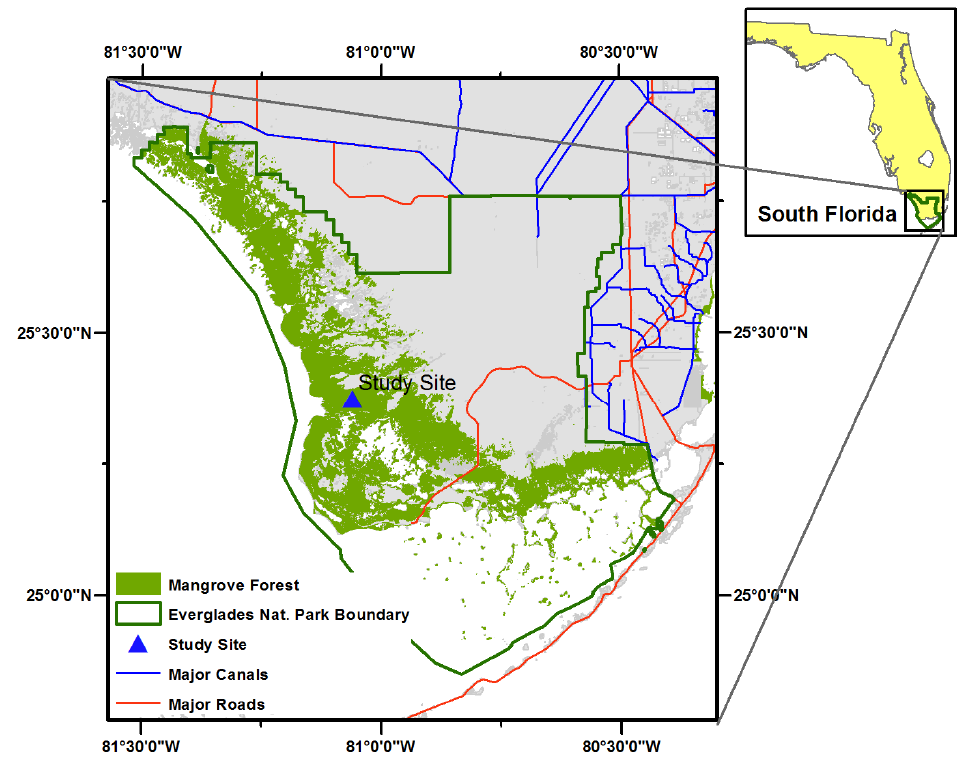
Fig. 1. Map of Everglades National Park, showing mangrove forest zones along the coast, the study site, and the park boundaries, defined by the thick green line. The 30m EC tower, SRS6, and SH3 are colocated at the study site.